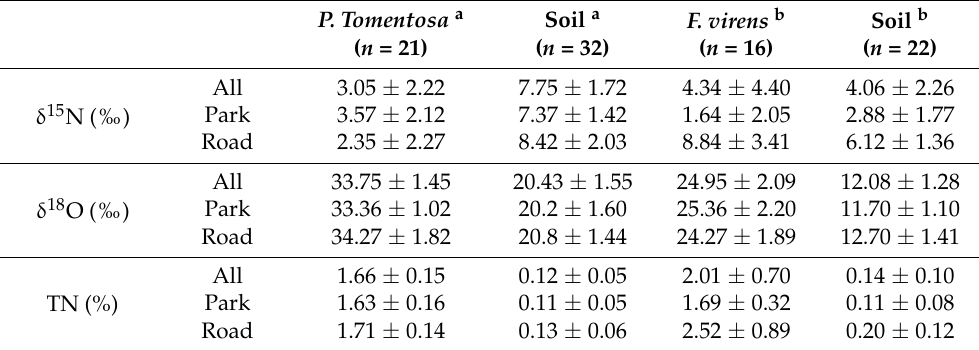
Table 4. Descriptive statistics of the plant and soil samples’ data (Note: a : Beijing samples. b : Shenzhen